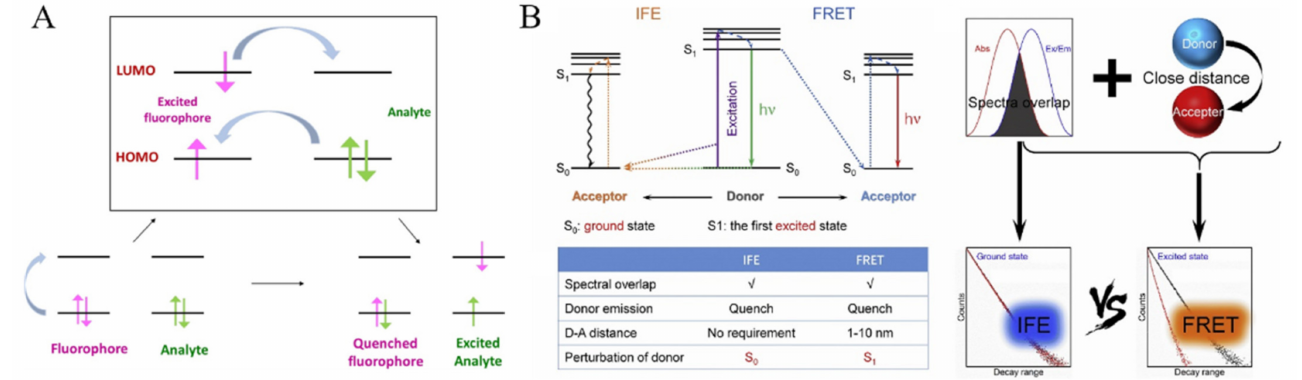
Figure 1. ( A ) Schematic illustration of the process of PET. Reproduced with permission [45]. Copy- right 2020, Elesvier. ( B ) Schematic illustration of the process of IFE and FRET. Reproduced with permission [46]. Copyright 2019,